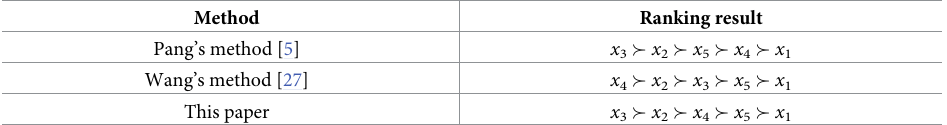
Table 8. The ranking results from different